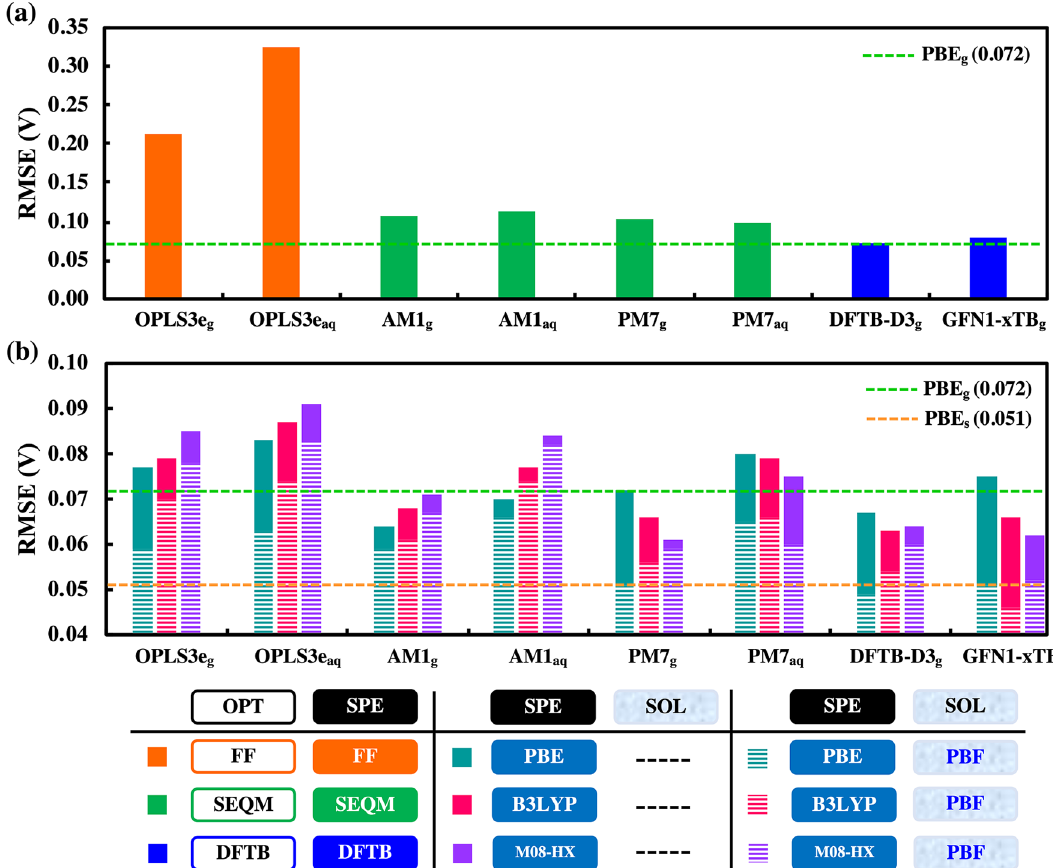
Figure 3. Performance comparisons of low-level methods: FF, SEQM and DFTB. ( a ) RMSE of SPE data calculated at the three different levels of theory. Similarly, ( b ) RMSE of DFT calculated SPE data on the geometries obtained from the three different levels of theory. In ( b ), the solid bars show SPE results without implicit solvation effects, whereas the dashed bars show results with implicit solvation effects taken into account. The dashed green horizontal line represents PBE g (R 2 = 0.954, RMSE = 0.072 V) benchmark and the dashed orange horizontal line represents PBE s (R 2 = 0.977, RMSE = 0.051 V)